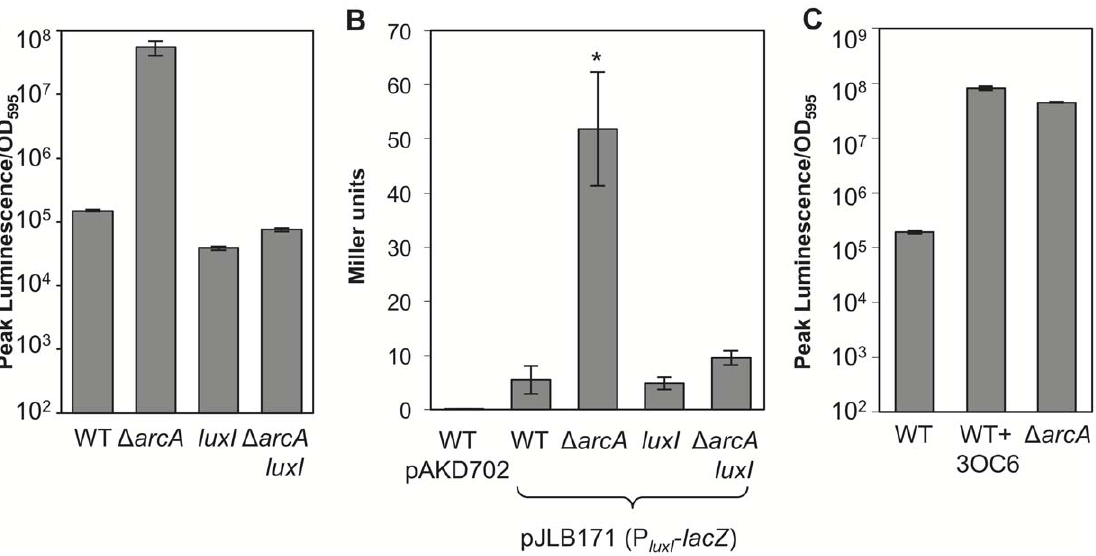
Figure 2. Effect of luxI and 3OC6 on derepression of the lux operon in an arcA mutant. Luminescence or lux reporter expression was measured in strains ES114 (WT), AMJ2 ( D arcA ), VCW2G7 ( luxI mutant), or ANS7 ( D arcA luxI ). (A) Peak specific luminescence (luminescence per OD 595 ) of strains grown in SWTO in aerobic shake flasks. Error bars indicate standard deviation (n=3). (B) Plasmid based P luxI - lacZ transcriptional reporter assays. Strains containing pJLB171 or the promoterless vector pAKD702 were grown in duplicate aerobic shake flasks in SWTO medium. Cells were harvested at peak luminescence for ß–galactosidase assays. Error bars indicate standard deviation (n=2). Asterisk indicates p-value of , 0.05 with a Student’s t-test comparing the arcA mutant to its respective parent strain. (C) Peak specific luminescence values for aerobic cultures grown in SWTO medium with 50 nM 3OC6 added where indicated. Error bars (some too small to see) indicate standard deviation (n=2). Each panel is representative of at least three independent experiments.